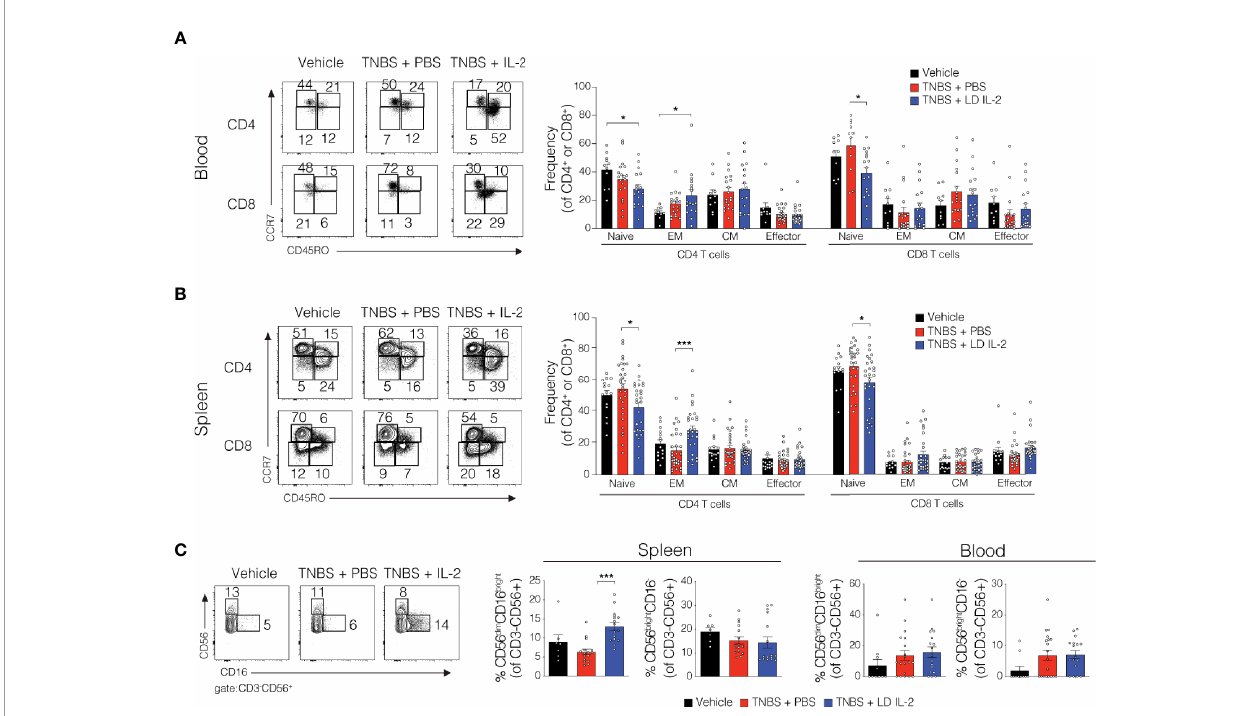
FIGURE 3 | Alteration in the lymphocyte population in blood and spleen of trinitrobenzensulfonic acid (TNBS)-induced colitis in humanized NOD. Prkdc scid Il2rg -/- (NSG) mice treated with low-dose (LD) interleukin-2 (IL-2). (A, B) Representative fl ow cytometry dot plots and quanti fi ed data of human CD4 + and CD8 + T cells subsets in blood and s pleen where each circle represents an individual mouse. (C) Representative fl ow cytometry dot plots and quanti fi ed frequencies of splenic and blood natural killer (NK) cell subsets 3 days post-rectal challenge in NSG human immune system (HIS) mice ( n ≥ 7). Data were pooled from three independent experiments and histograms depict the mean ± SEM. * P < 0.05, *** P <